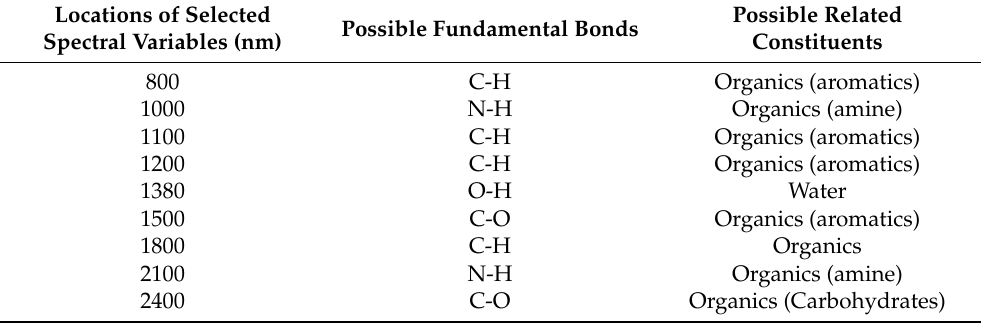
Table 3. Basic chemical bonds, absorption wavelengths, and possible associated water pollution components of main spectral bands screened by competitive adaptive reweighted sampling (CARS) for visible near-infrared region.